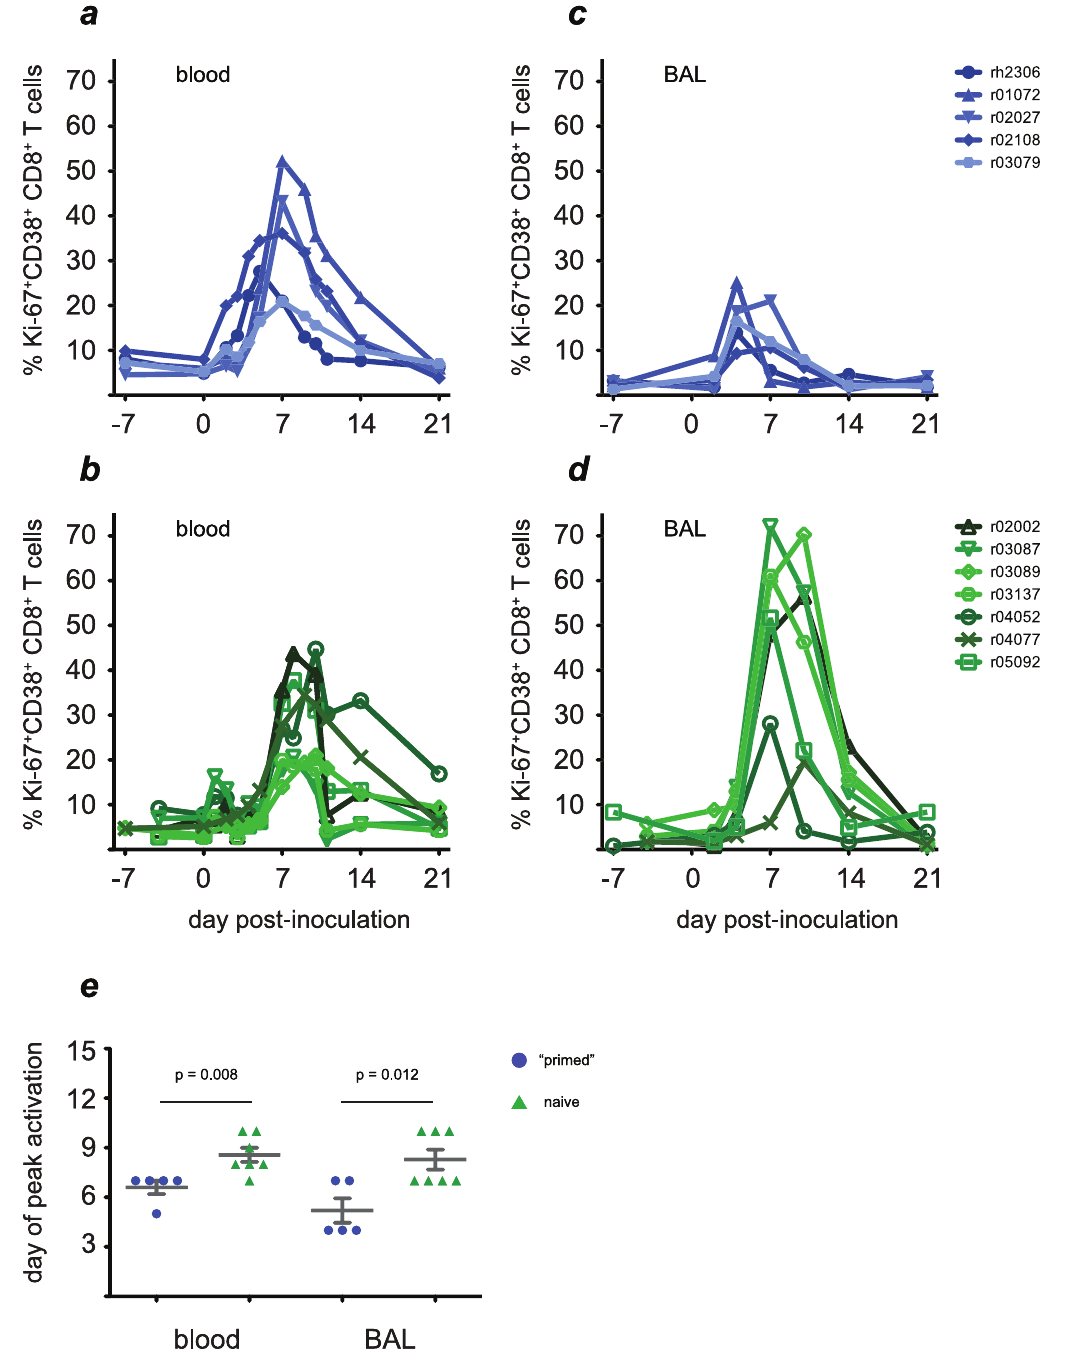
Figure 4. Activated CD8 + T cell populations increase rapidly in the blood and lungs of ‘‘primed’’ animals after challenge with H1N1pdm. Four months after infection with the K173 seasonal isolate, we challenged the 5 previously infected macaques (blue traces, solid symbols) and 7 naive control animals (green traces, open symbols) with 9 million pfu of H1N1pdm isolate A/California/04/2009 (CA04) and monitored the kinetics of CD8 + T cell activation. a and b , CD8 + T cell activation kinetics in blood. c and d , CD8 + T cell activation kinetics in lung, assessed using cells recovered from bronchoalveolar lavage (BAL). e , Peak levels of activation are reached significantly earlier in both compartments in ‘‘primed’’ animals than in naive animals. infection that could be recalled after H1N1pdm challenge, for (autologous) HA sequence in order to detect responses against the these assays we used the same set of overlapping peptides divergent HA of the challenge virus. As shown in Fig. 5 , ‘‘primed’’ representing the entire influenza virus proteome as we did to animals swiftly mounted virus-specific T cell responses upon measure responses to the initial K173 infection in the ‘‘primed’’ challenge with H1N1pdm. These responses peaked on day 7 post- animals, except these assays used peptides representing the CA04 infection in all 5 ‘‘primed’’ animals. The peak magnitude of the